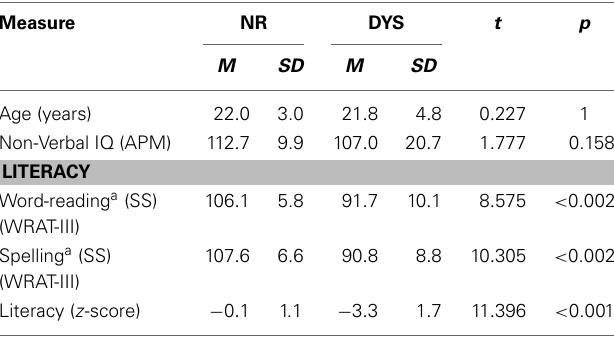
Table 1 | Participant